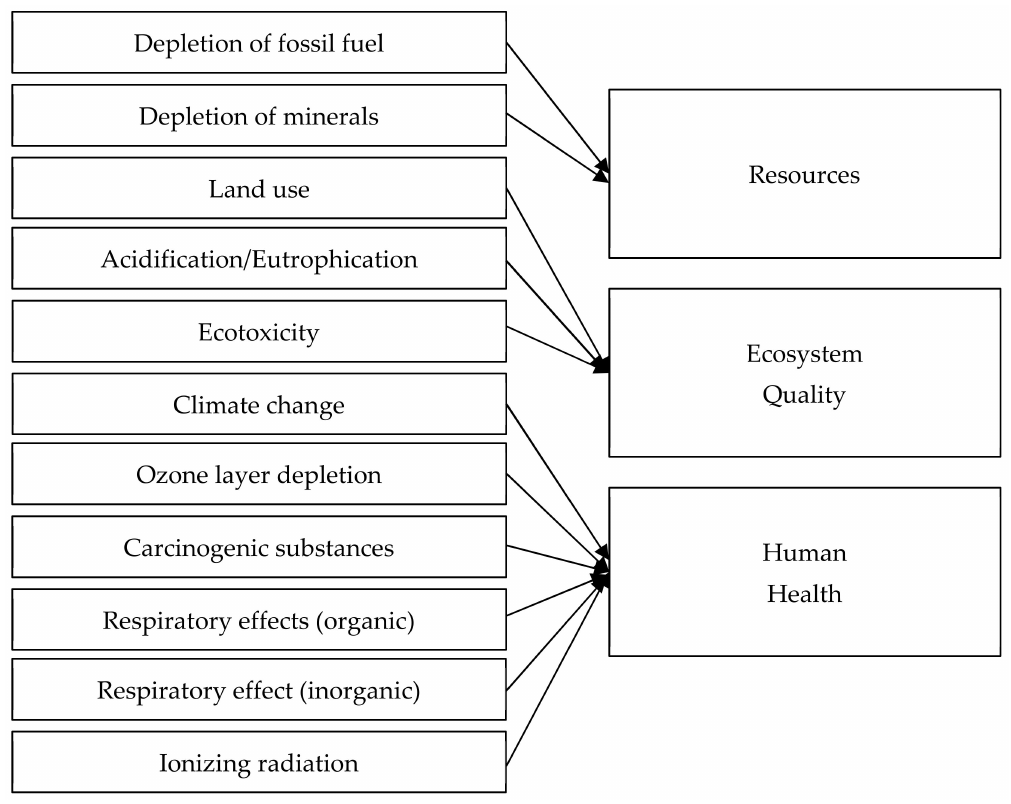
Figure 3. Structure of LCA impact category groupings, Eco-indicator 99